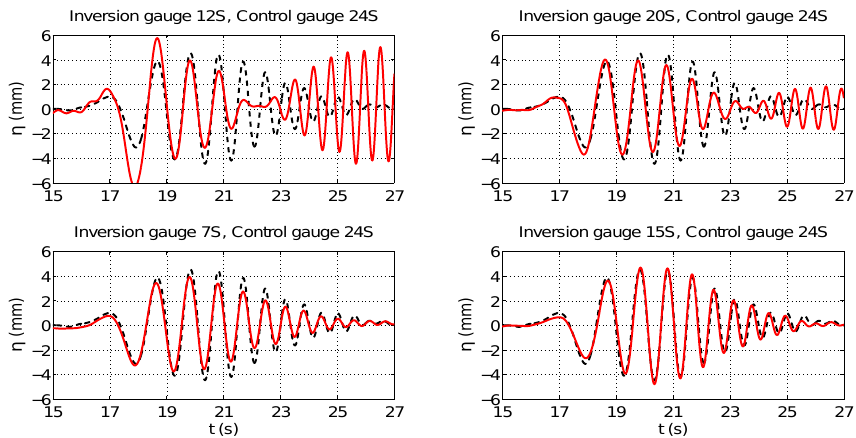
Fig. 5. Comparison of the numerical result (red solid line) with the experimental time series (black dashed line) at the control gauge 24S. Each plot refers to a different gauge (12S, 20S, 7S and 15S) used for the inversion.